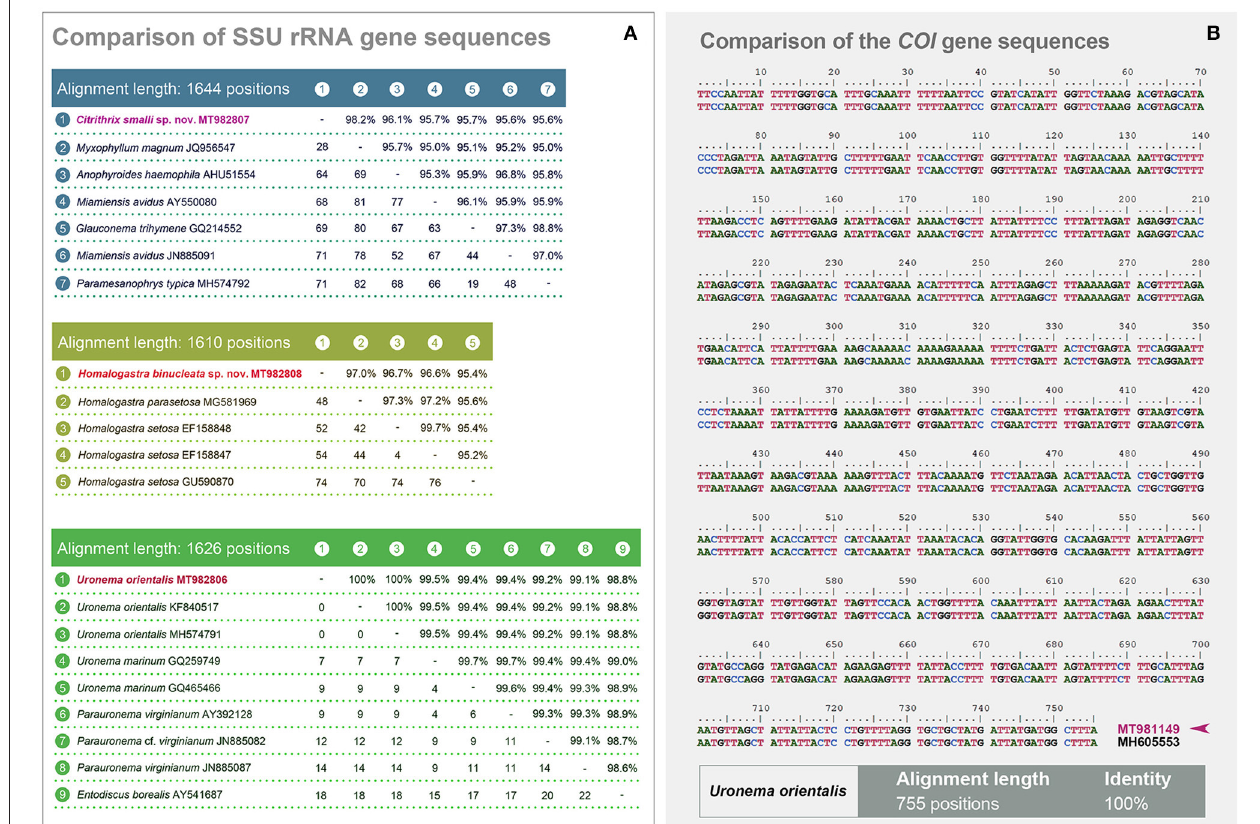
FIGURE 6 | (A, B) Comparisons of SSU rRNA and the COI gene sequences. (A) Comparisons of the SSU rRNA gene sequences of Citrithrix smalli sp. nov. (upper matrix), Homalogastra binucleata sp. nov. (middle matrix), and Uronema orientalis Pan et al., 2015 (lower matrix), with their related sequences. The lengths of each alignment after trimming both ends are shown. The lower left values in each matrix are numbers of unmatched nucleotides, while the upper right numbers indicate the sequence identity. (B) Comparison of the COI gene sequences between Uronema orientalis MT981149 (from the present study, with arrowhead) and Uronema orientalis MH605553 (from the original population). The final alignment length is 755 positions, with a 100% sequence identity.